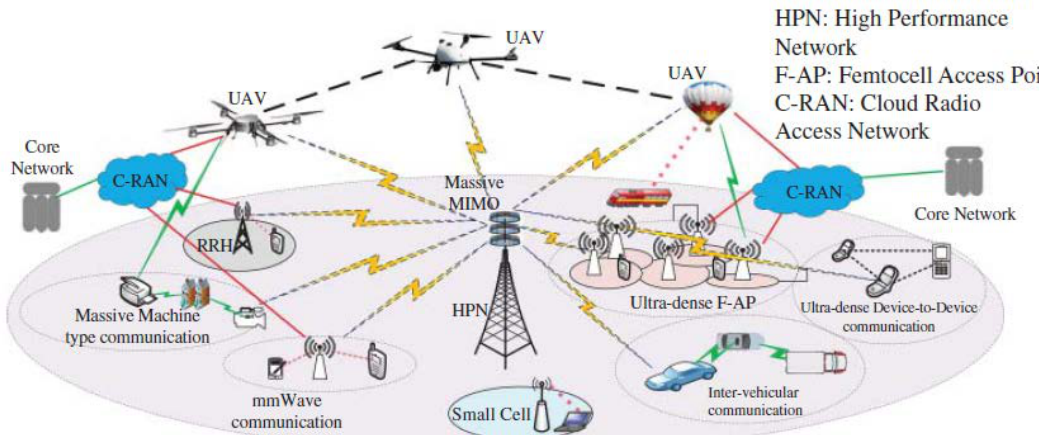
Figure 1. 5G ultra-dense network architecture (after [9] and [14]). UAV: unmanned aerial